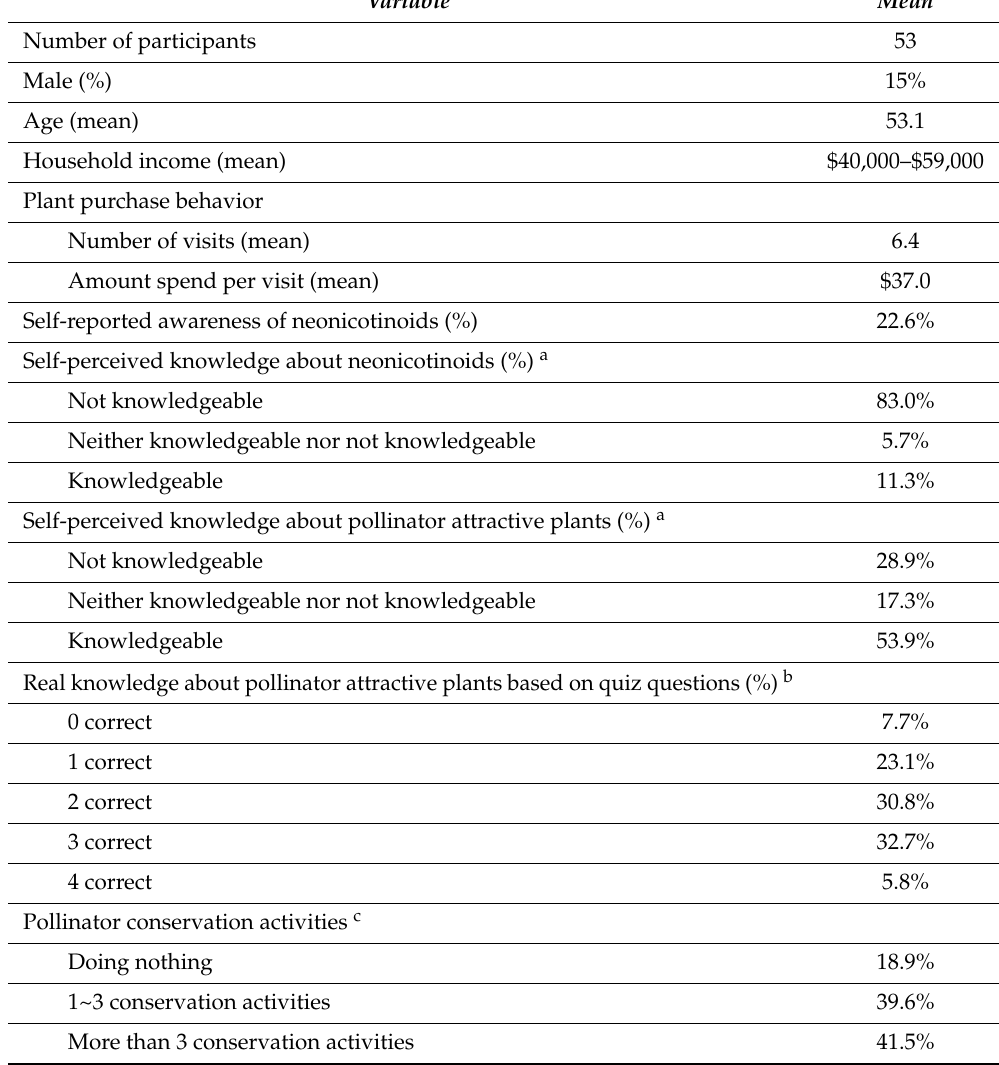
Table 2. Participants’ sociodemographic